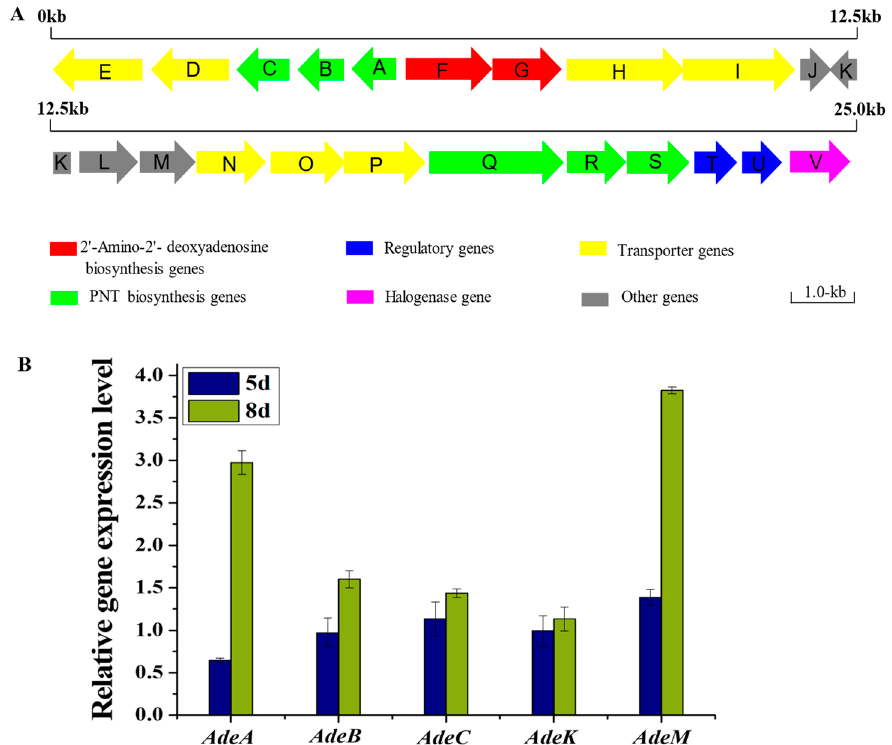
Figure 5. RT-qPCR analysis of the transcription levels of different genes in Actinomadura sp. S-15 and Actinomadura sp. ATCC 39365. ( A ) Genetic organization of co-transcription units in pentostatin biosynthetic gene cluster ( AdeA-AdeV ) [10]. ( B ) Relative expression levels of pentostatin biosynthesis gene cluster in Actinomadura sp. S-15, compared with those in Actinomadura sp. ATCC 39365. Five genes were selected to indicate the expression level of co-transcription units.